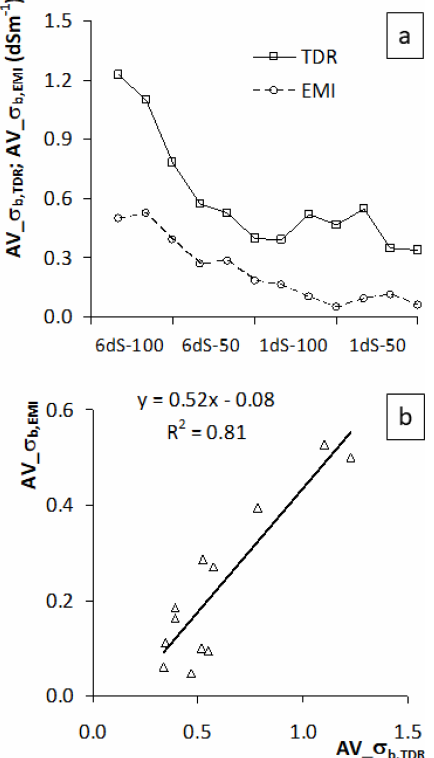
Figure 9. (a) Comparison of the standard deviations of the TDR original series (squares and solid line), of the EMI original se- ries (circles and dashed line), and of the filtered (FLT) TDR series (crosses and dashed line) and (b) the same comparison on a 1:1 plot: the original TDR and EMI data (triangles and solid regression line); filtered (FLT) TDR and original EMI data (squares and dashed regression line). In (a) , the four cases are shown in sequence. For each case, the three values are for the three depth intervals 0.0–0.2, 0.2–0.4 and